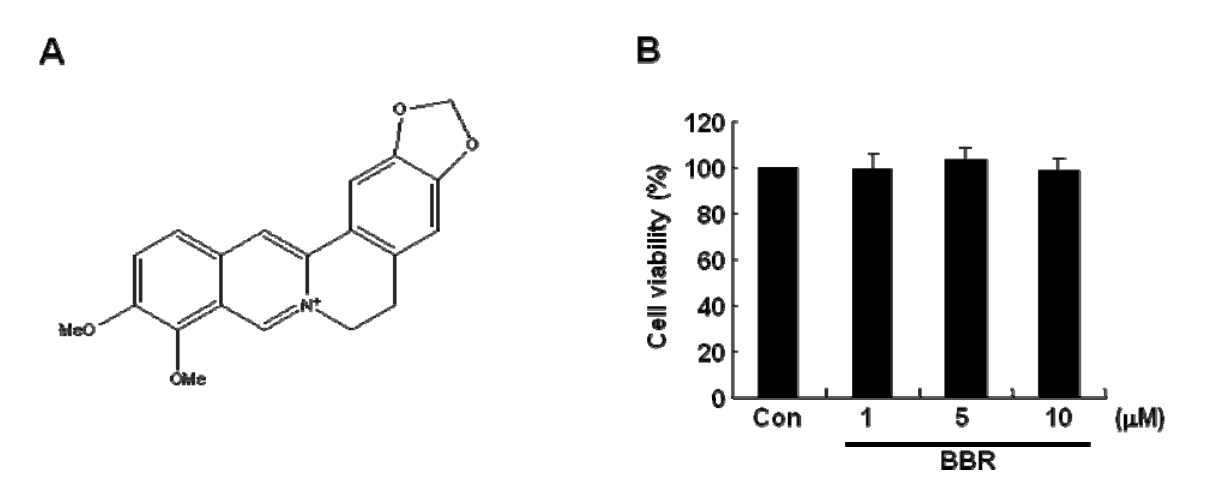
Figure 1. The viability of MDA-MB-231 cells with treatment of berberine in different concentration. After serum-starvation for 16 h, cells treated with berberine at the indicated concentration for 48 h in fresh serum-free media. (A) Berberine structure. (B) Cell viabilities were analyzed by MTT assay as described in Materials and Methods. These results were representative of three independent experiments. Values shown are means ± SEM. Con;